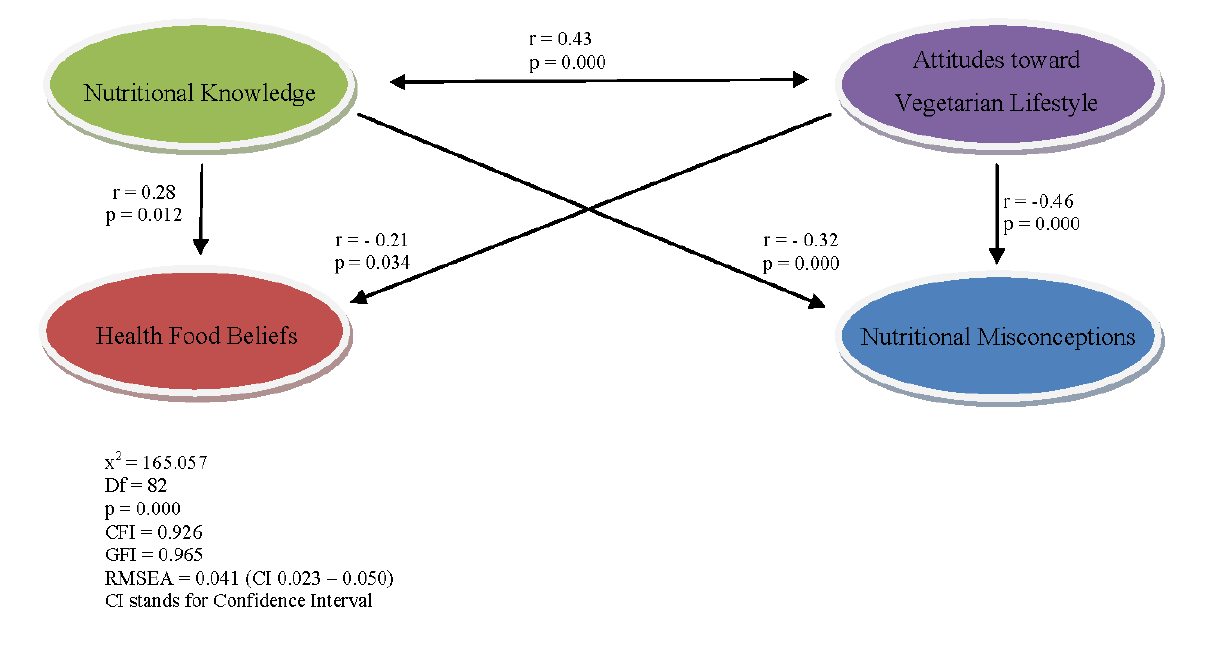
Figure 2. Structural Equation Modeling testing a theoretical model of the relationship between attitudes, beliefs, knowledge and misconceptions concerning vegetarian